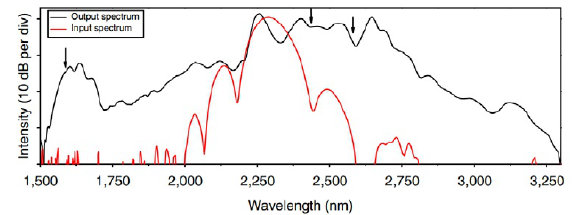
Fig. 22. An octave spanning coherent supercontinuum. The spec- trum of the 60 fs long, 225 W peak power pump pulses is spectrally broadened over more than an octave in a 1 cm long, 1600 nm wide and 390 snm high, slightly overetched waveguide. Adapted from reference [66].